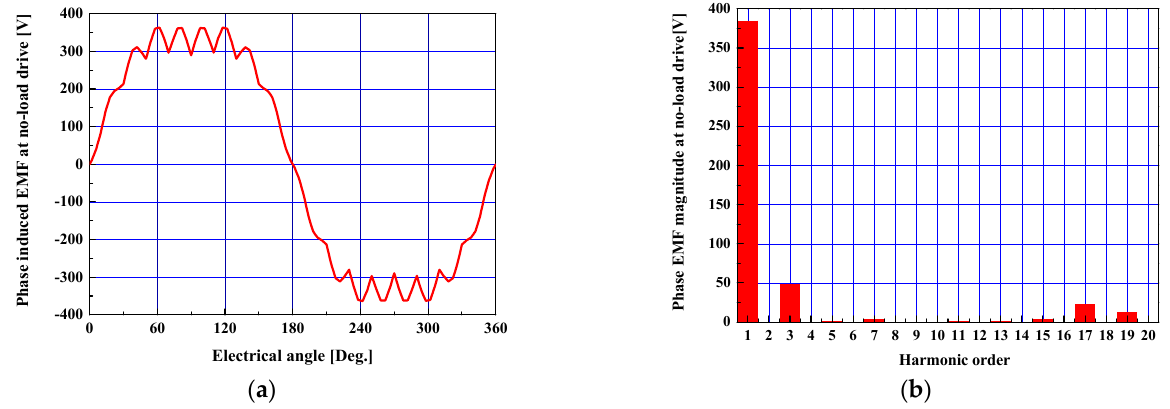
Figure 4. Induced EMF at no-load drive for the initial design: ( a ) wave form, and ( b ) harmonic order.